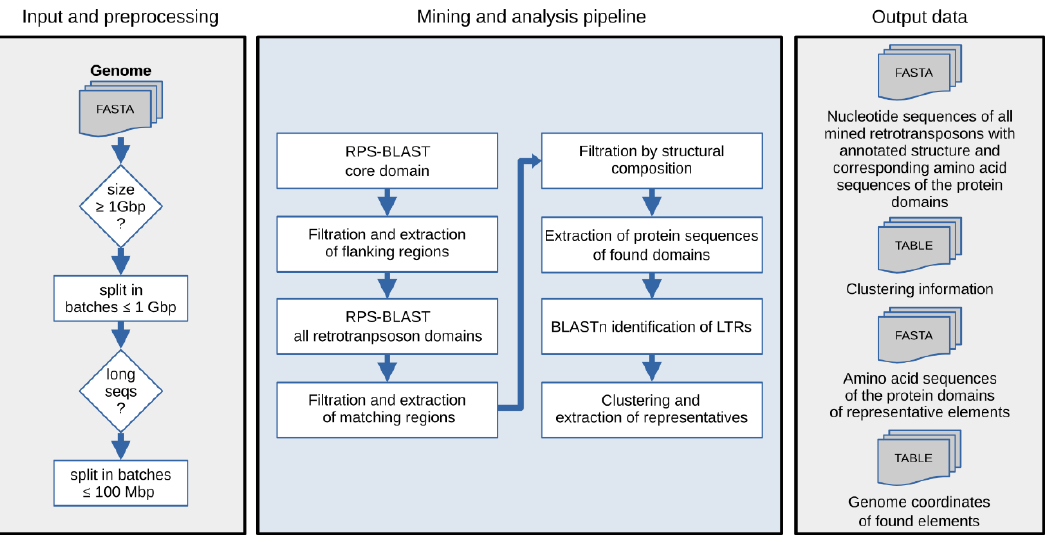
Figure 1. Principle scheme of the DARTS (Domain-Associated Retrotransposon Search) workflow. Detailed description of each step is in the text.